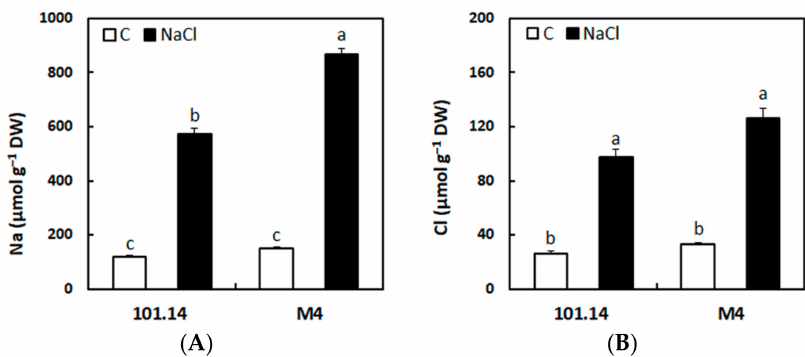
Figure 1. Levels of Na + ( A ) and Cl − ( B ) in roots of M4 and 101.14 grapevine rootstocks grown for 21 days in control ( (cid:3) ) or salt stress ( (cid:4) ) conditions. The values are the means ± Standard Error (SE) of three biological replicates ( n = 3). The statistical significance was assessed by analysis of variance (ANOVA) test ( p < 0.05, Tukey post hoc